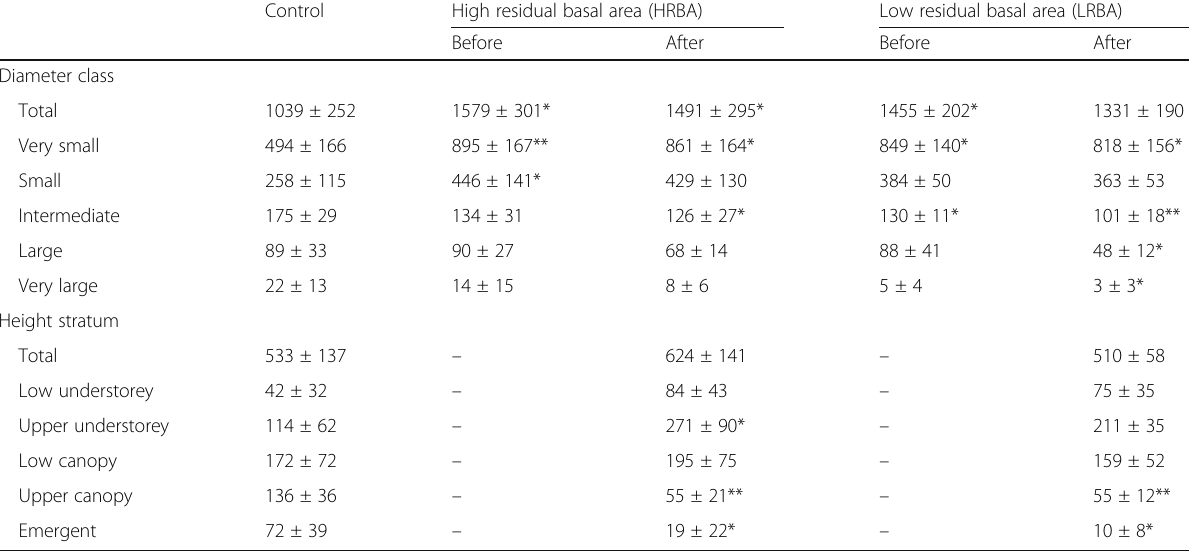
Table 4 Mean number of trees per hectare per diameter class (trees dbh ≥ 5 cm) and height strata (trees dbh ≥ 10 cm) before and after harvesting. Diameter classes and height strata are explained in Table 3. Values are expressed as mean ± 1 standard deviation. Significant treatment differences with the control are shown through an asterisk after the mean number of trees, with * p = 0.05